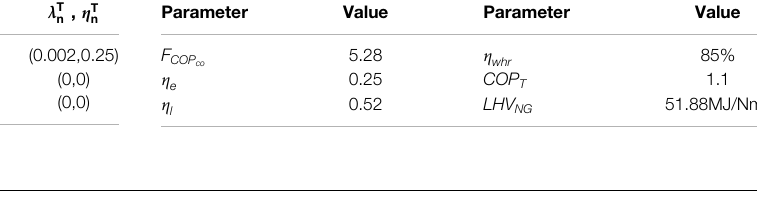
TABLE 6 | Electrical load elastic coef fi cient for different BCs.